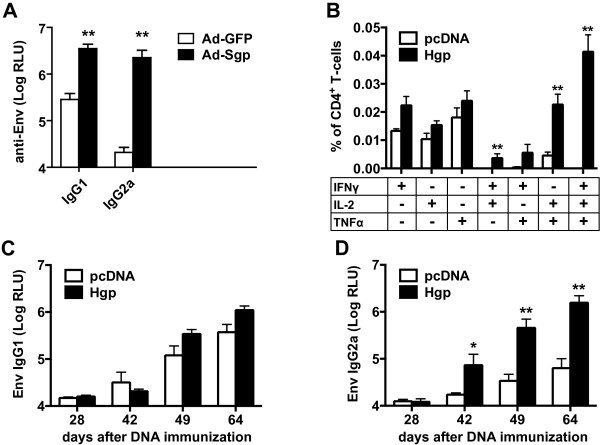
Intrastructural help for HIV Env. A) Mice were immunized with Ad-Sgp and boosted with SIV VLPs containing HIV Env 6 and 9 weeks later. Mean and SEM of Env-specific IgG1 and IgG2a antibody levels 2 weeks after the last VLP immunization from 6 animals per group are given. B-D) Mice were immunized with an HIV GagPol expression plasmid (Hgp) or empty pcDNA as control by intramuscular DNA electroporation. Gag specific CD4+ T-cell responses were analyzed 14 days after priming by intracellular cytokine staining of in vitro restimulated splenocytes. Shown are the percentages of cytokine producing cells among the total CD4+ T-cell population (B). HIV gp120 specific antibody levels of the subtypes IgG1 (C) and IgG2a (D) in the sera of immunized mice were determined by ELISA four weeks after DNA prime (day 28), one and two weeks after the first (day 42 and 49) and one week after the second VLP boost (day 64). Columns represent the mean values with SEM of 5–6 animals. *P < 0.05, **P < 0.005, Mann Whitney U test.